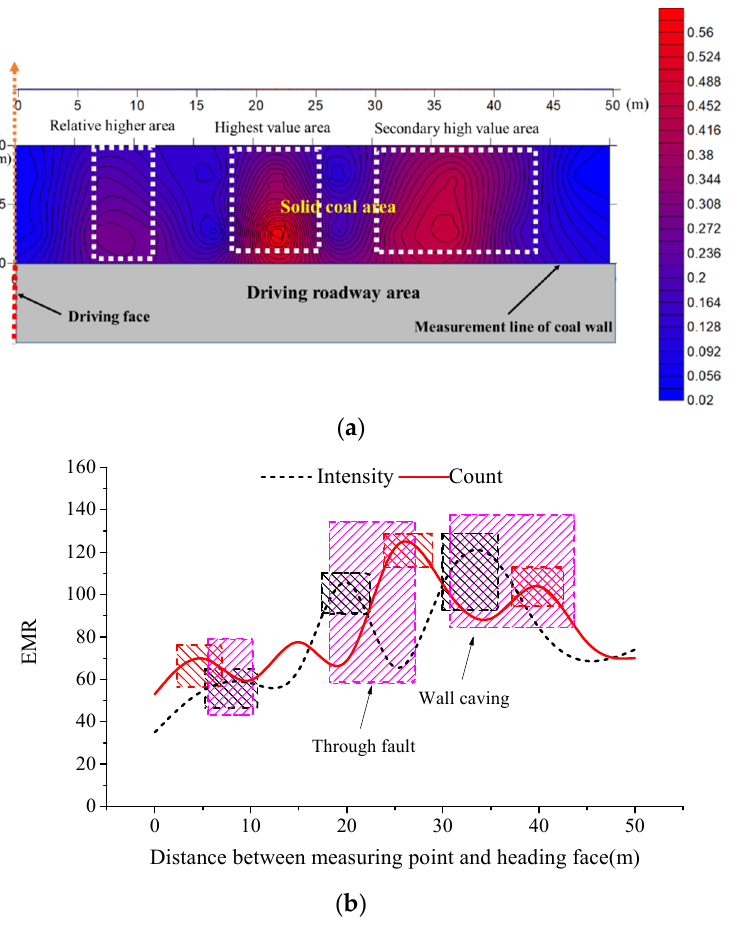
Figure 8. EP inversion results and EMR monitoring results behind the driving distance. ( a ) EP inversion distribution cloud map; ( b ) EMR indexes of intensity and count.